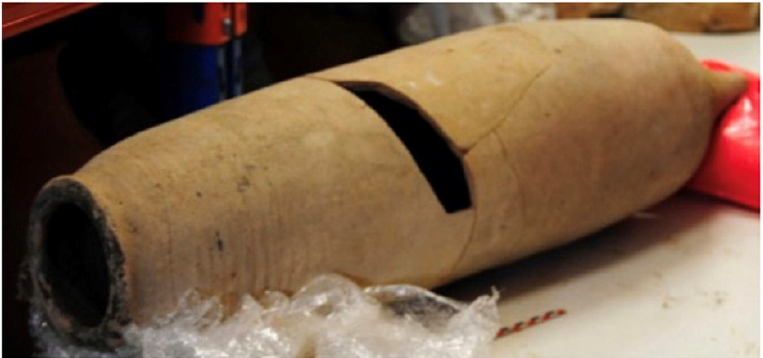
Figure 7. The torpedo jar from which the sample was taken. Image courtesy of Seth Priestman.